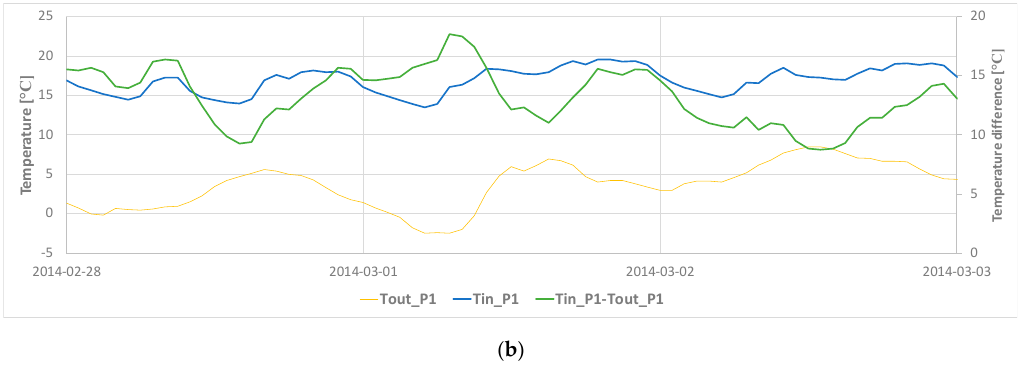
Figure 2. Indoor temperature, outdoor temperature and temperature difference: ( a ) for the whole dataset in Loughborough, ( b ) for period 1 in Loughborough.